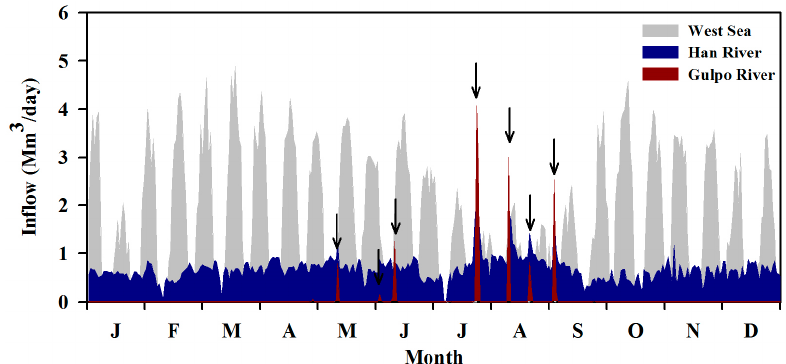
Figure 2. Total inflows of the West Sea, Han River, and Gulpo River in 2014. Arrows indicate times corresponding to Gulpo River diversion. Table 2. Comparison of water quality parameters for the Han River, Gulpo River, and West Sea in 2014.